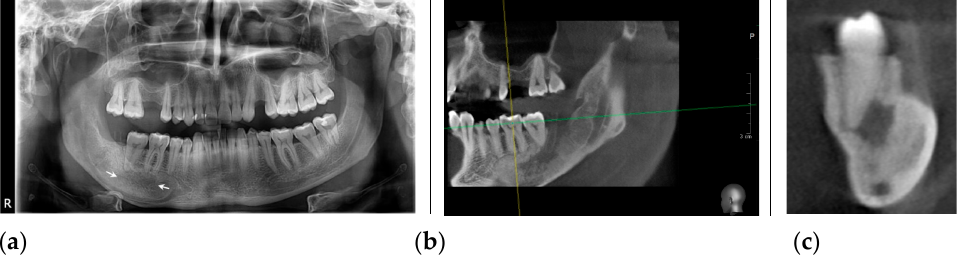
Figure 6. The radiological aspect: ( a ) Orthopantomography shows the healing process in the ascend- ant ramus, and the remaining osteolytic lesion at the apical region of the first and second mandibu- lar molars (arrows), one year after marsupialization; ( b ) The CBCT, sagittal view indicates unmod- ified bone structure near the molar #46 apices; ( c ) The CBCT, sagittal view of molar #47 demonstrates the lesion contact and the enlarger of periodontal space.